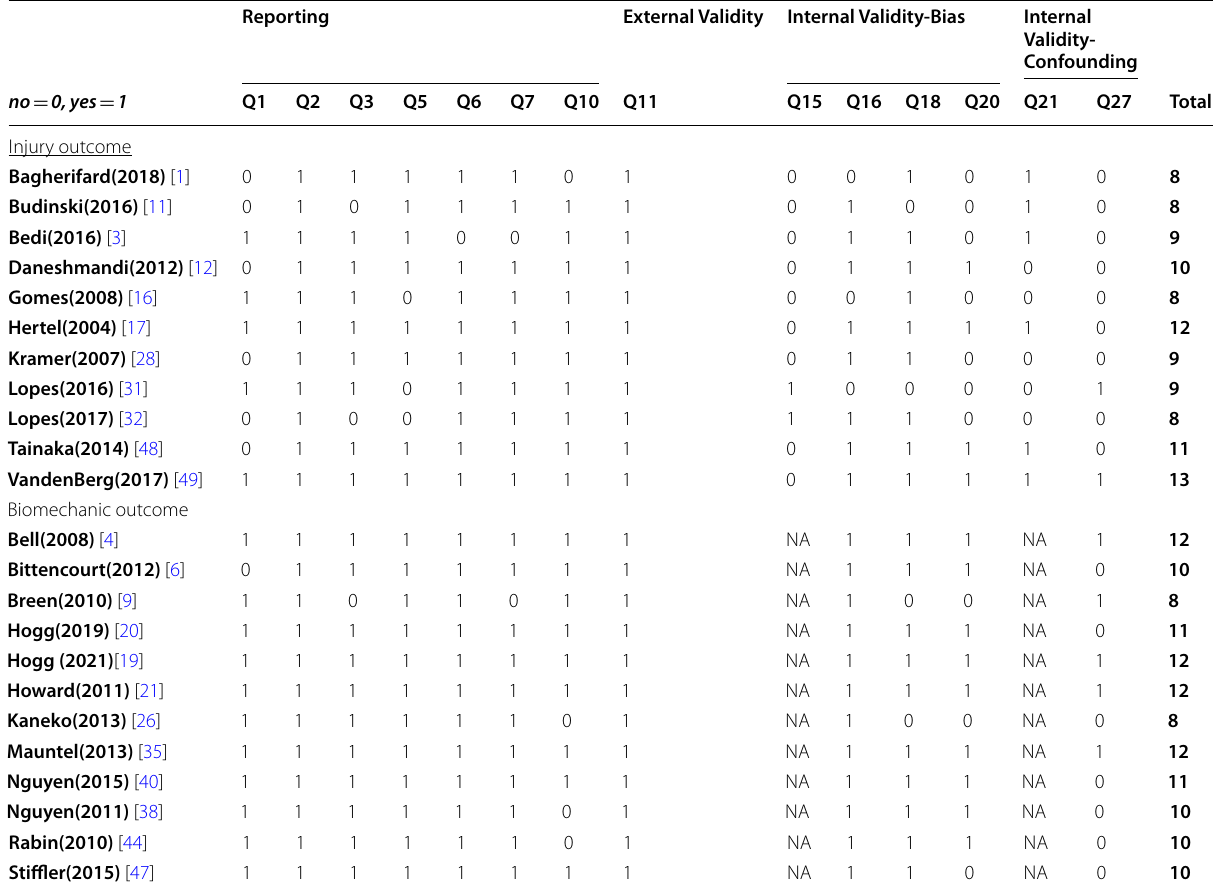
Table 4 Downs & Black Quality Index Scores for included studies